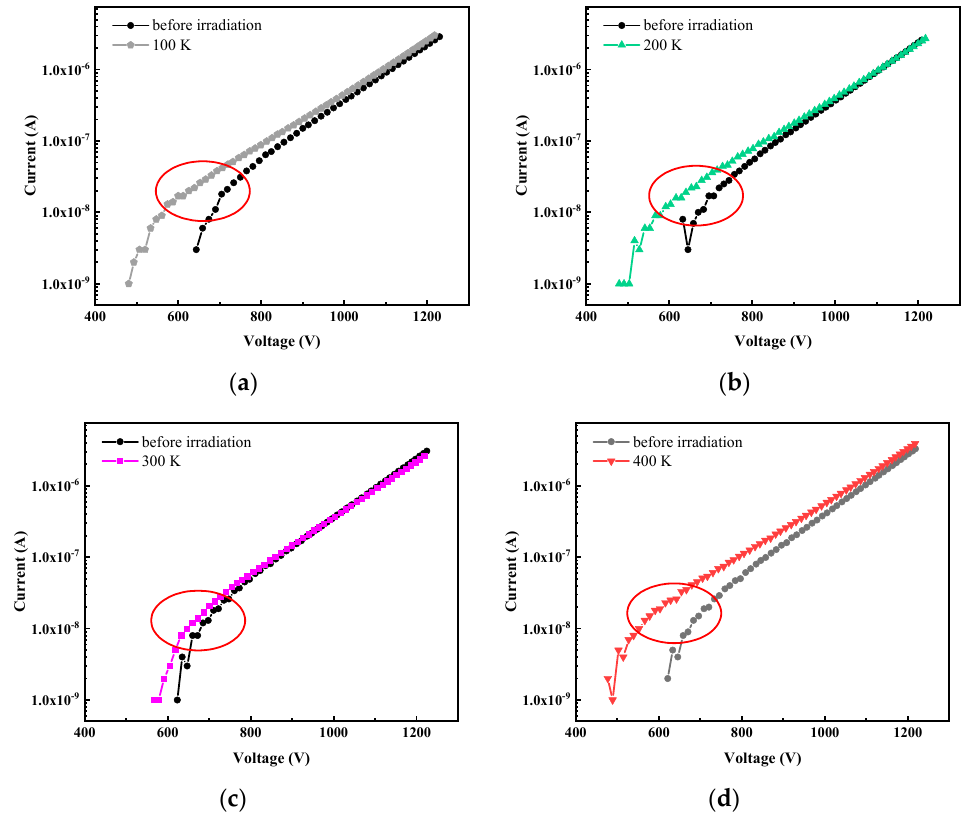
Figure 6. Semilogarithmic reverse I–V characteristics of the 4H-SiC JBS diodes before and after irradiation at irradiation temperatures of ( a ) 100 K, ( b ) 200 K, ( c ) 300 K, and ( d ) 400 K.